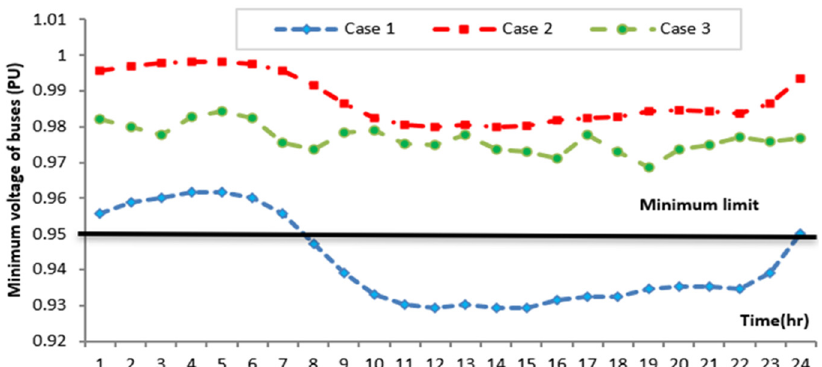
Figure 21. Minimum voltage profiles for different cases studied at each hour for the second MG.